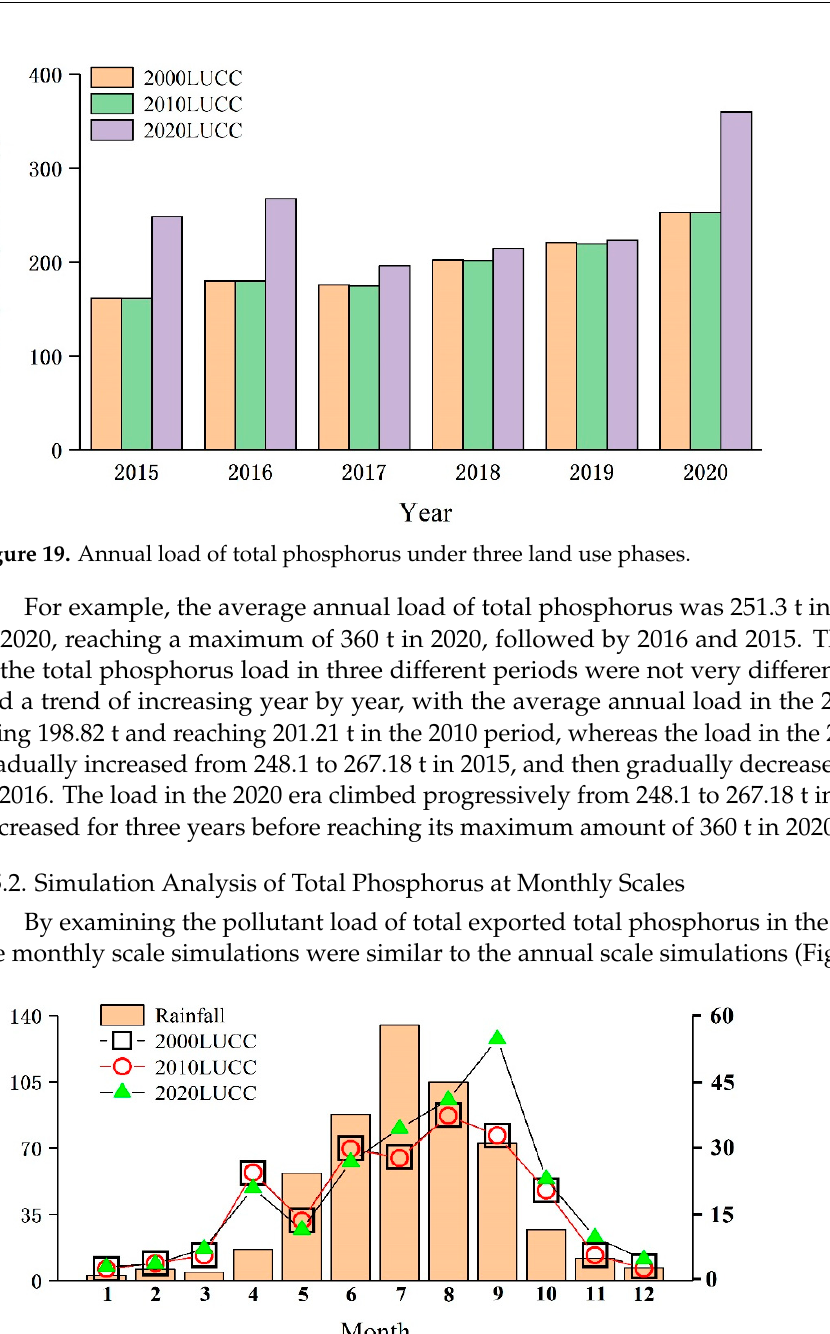
Figure 20. Annual total phosphorus monthly loadings under three land use phases.